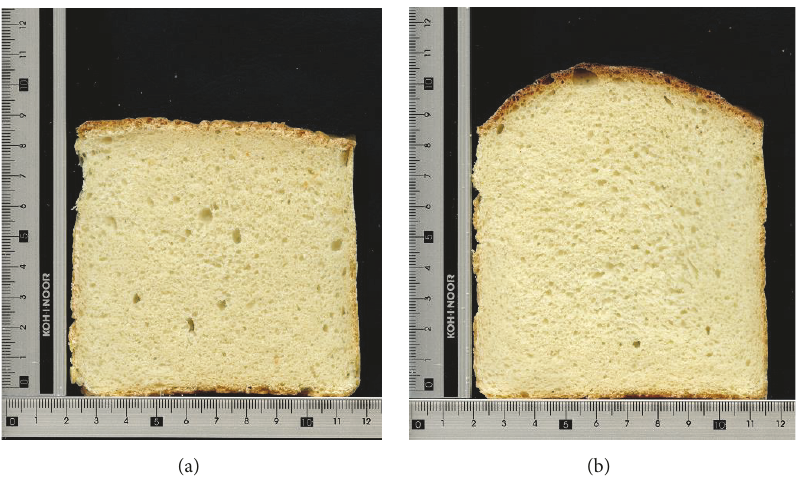
Figure 2: Pan bread sections: (a) 4TC and (b)